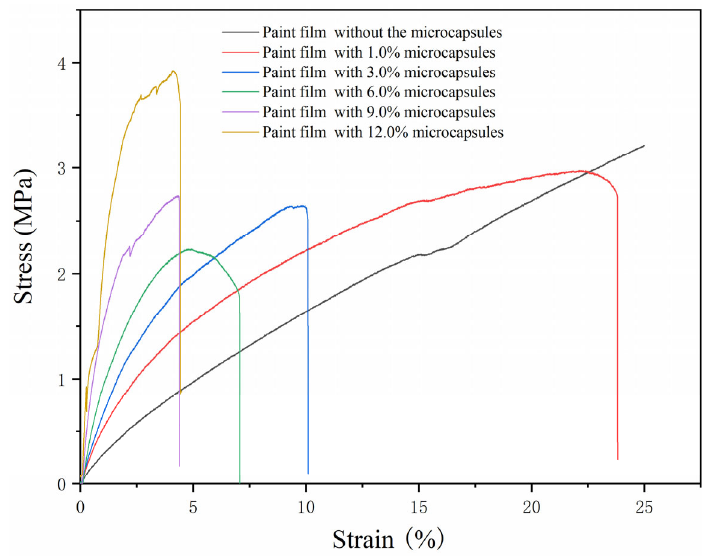
Figure 17. The stress–strain curves of the paint films. Table 15. Elongation at the break of the paint films.